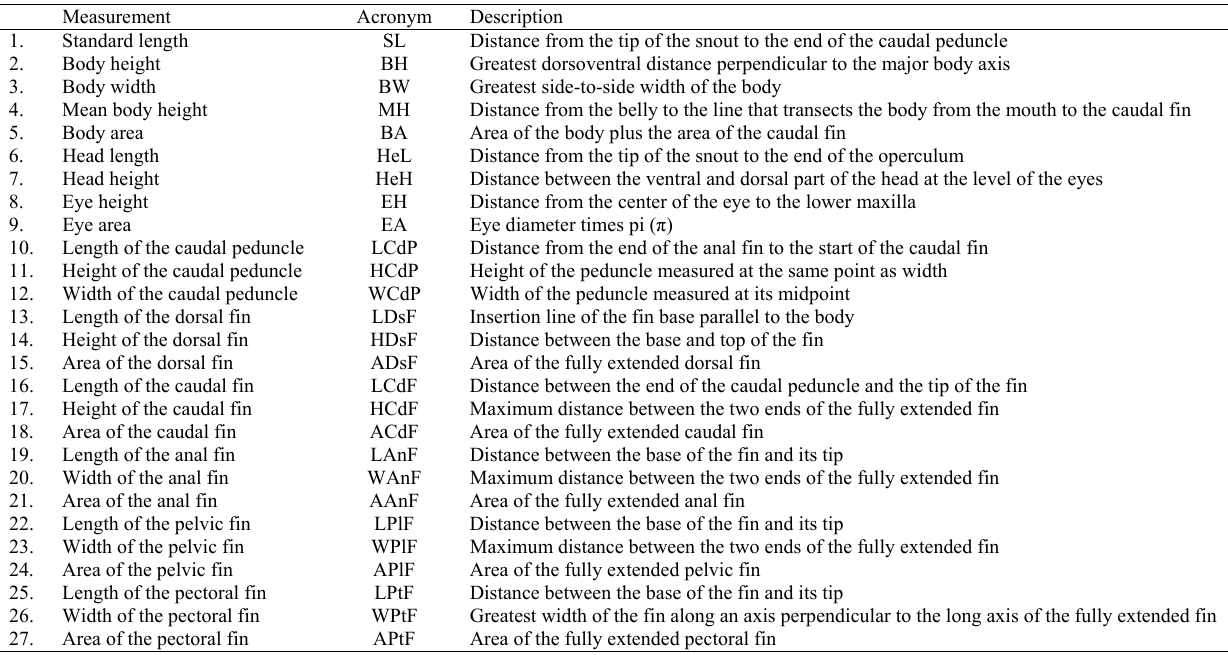
Table 1. Morphometric measurements taken from examined individuals and their